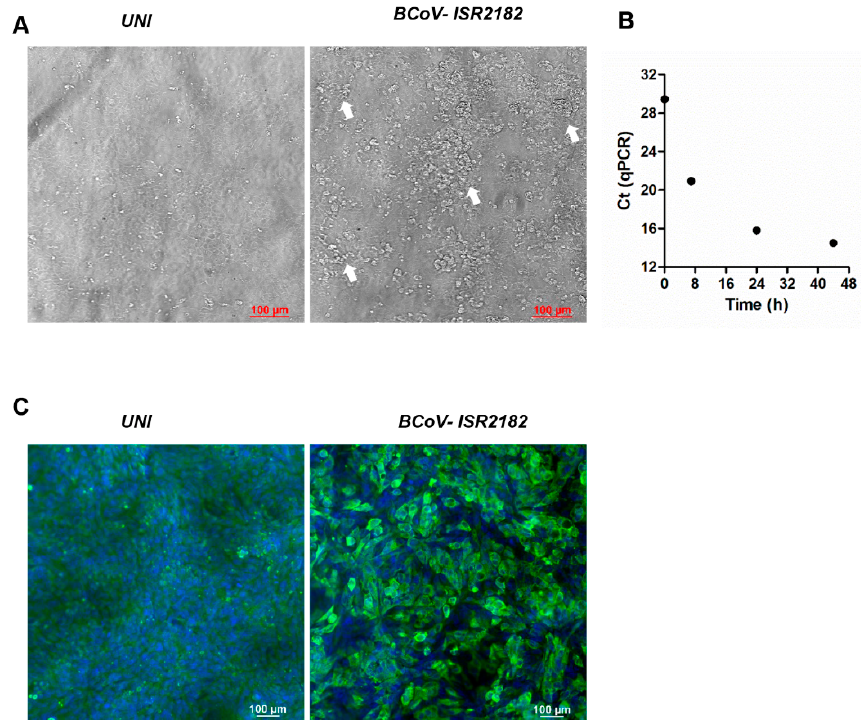
Figure 1. Cytopathic effect and replication of Bovine coronavirus (BCoV) isolate ISR2182. ( A ) Un- infected HRT-18G cells show intact monolayer, while cells infected with local isolate ISR2182 (1:10) for 72 h show significant changes in monolayer (white arrows). ( B ) Replication of BCoV ISR2182 in HRT-18G, cells were infected with isolate ISR2182 and collected at different time points. BCoV replication was measured by RT-qPCR. ( C ) Immunofluorescence images showing replication of BCoV isolate ISR2182 in HRT-18G cells as detected by monoclonal antibody-targeting coronavirus nucleocapsid protein, with DAPI for nucleus staining.